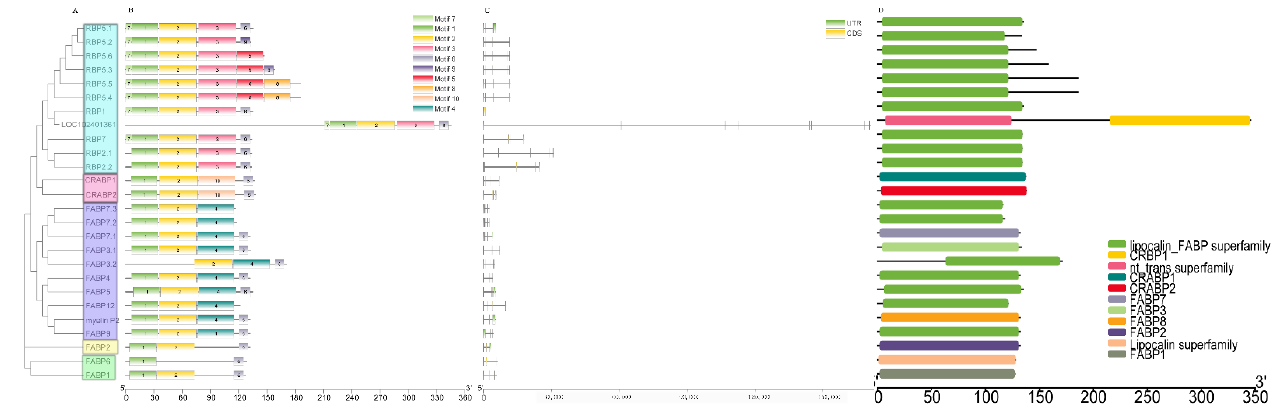
Figure 1. Representations of the recognized FABP proteins and genes isoforms in buffalo. ( A ) The phylogenetic tree was constructed by the N-J method. ( B ) The structure of amino acid sequence boxes represents ten conserved motifs. In the gene structure plot ( C ), the green box, black line, and orange box represent untranslated region (UTR), intron, and coding sequencing (CDS), respectively. Conserved domains ( D ) were searched by NIBI-CCD search.